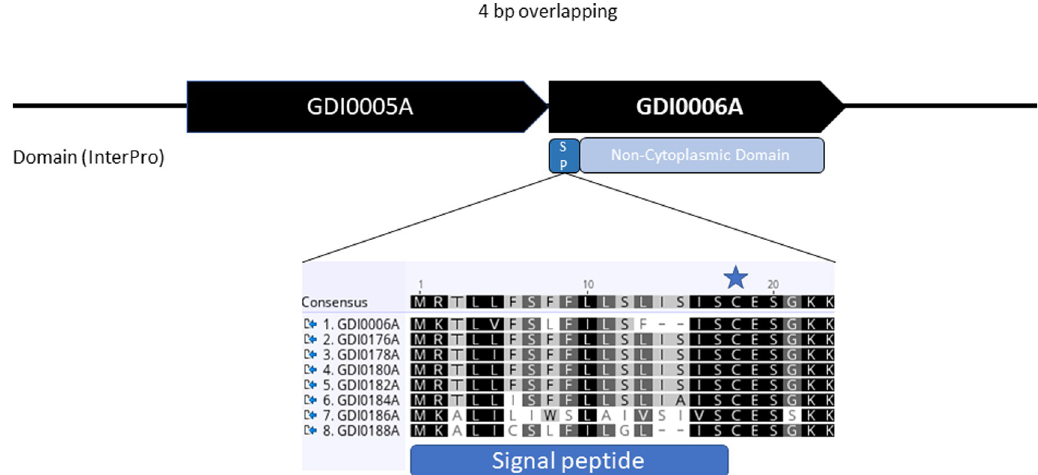
Fig 1. Characteristics of the GDI0005A and GDI0006A operon from Chryseobacterium arthrosphaerae ZSTG2175 genome. (A) The two GDI0005A and GDI0006A open reading frames overlap by 4 nucleotides. (B) Sequence overview of the signal peptide from all GDI00006A protein family members. The blue star indicates the potential cleavage site between the serine and the cysteine amino acid predicted by the SignalP5.0 algorithm. https://doi.org/10.1371/journal.pone.0267220.g001 [52]. As expected in bioassays, the lysate of Gpp34Ab1/Tpp35Ab1 recombinant proteins caused only a partial loss of weight (0.3 mg versus 0.5 mg) in larvae from Gpp34Ab1/